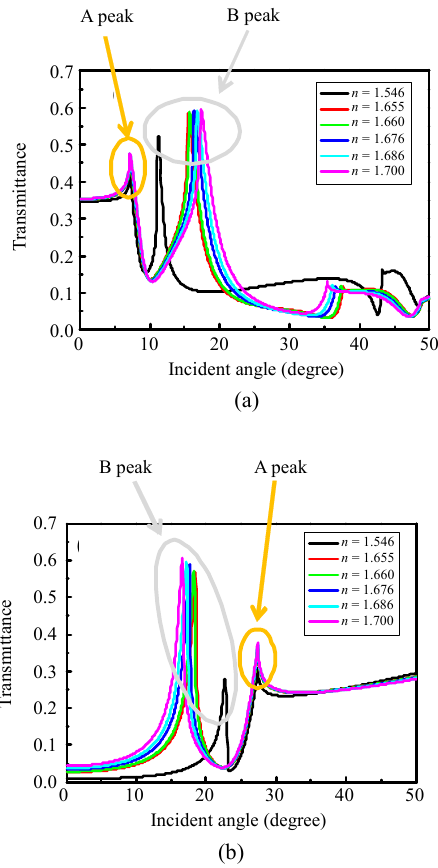
Fig. 4 Simulation results for the transmittance as a function of the incident angle spectra between 0 ° and 50 ° for a varying refractive index: (a) period of 500 nm and (b) period of 300